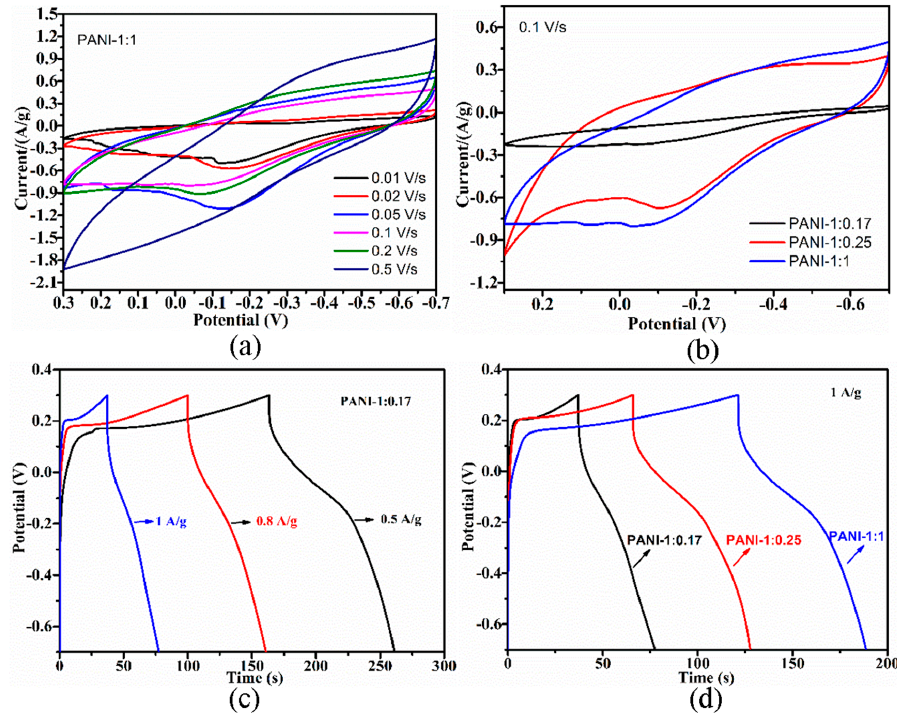
Figure 6. ( a ) CV curves of PANI-1:1 electrode at different scan rates. ( b ) CV curves of different PANI electrodes at the scan rate of 0.1 V/s. ( c ) Charge-discharge plots of PANI-1:0.17 electrode at different current densities. ( d ) Charge-discharge plots of different PANI electrodes at the current density of 1 A/g.